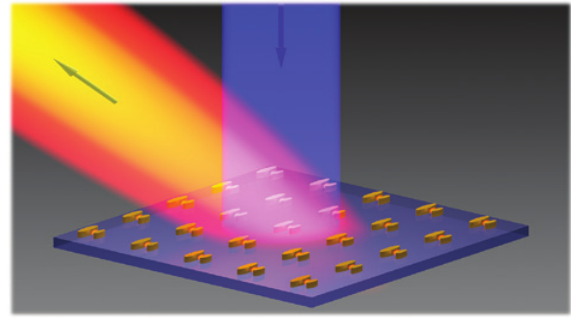
Figure 1: Artist’s impression of a light-emitting metasurface. The pump beam (blue) excites fluorescent emitters integrated with periodically arranged nanoantennas. The direction of emitted light (orange) can be controlled by proper design of individual nanoantennas and their arrangement. In the illustrated example, the emission is strongly